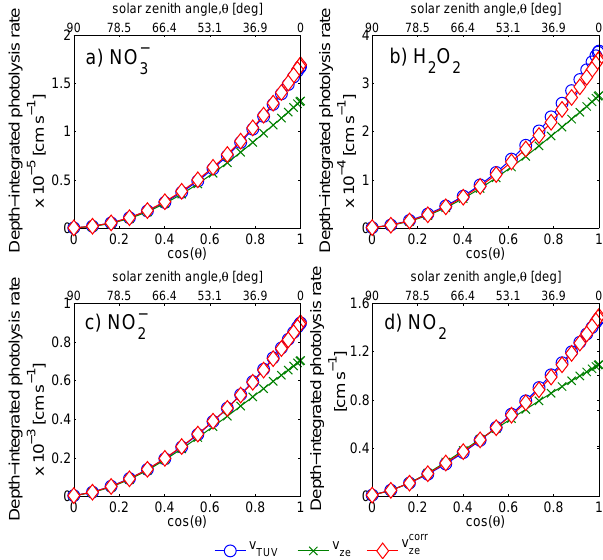
Figure 8. Depth-integrated photolysis rate coefficient at various solar zenith angle for different species within snowpack Scatt2 ( ρ = 0.4gcm − 3 , [BC] = 4ng ( C ) g − 1 and σ scatt = 2m 2 kg − 1 ). (a) Depth-integrated photolysis rate coefficient of the NO − anion; anion; (b) depth-integrated photolysis rate coefficient of H 2 O 2 ; 3 (c) depth-integrated photolysis rate coefficient of the NO − anion; (d) depth- (d) depth-integrated photolysis rate coefficient of NO 2 ; blue circle 2 – v TUV , computed by TUV; green cross – v z , calculated by the e -folding e -folding depth method; red diamond – v Corr z e , corrected v z by coefficients coefficients listed in Table e e